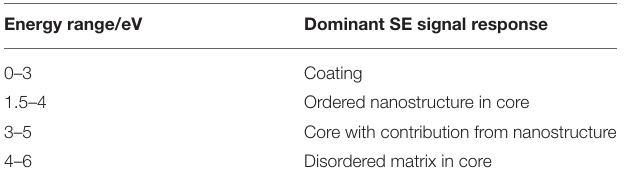
TABLE 1 | Summary of energy ranges used to isolate compositions on different scales.